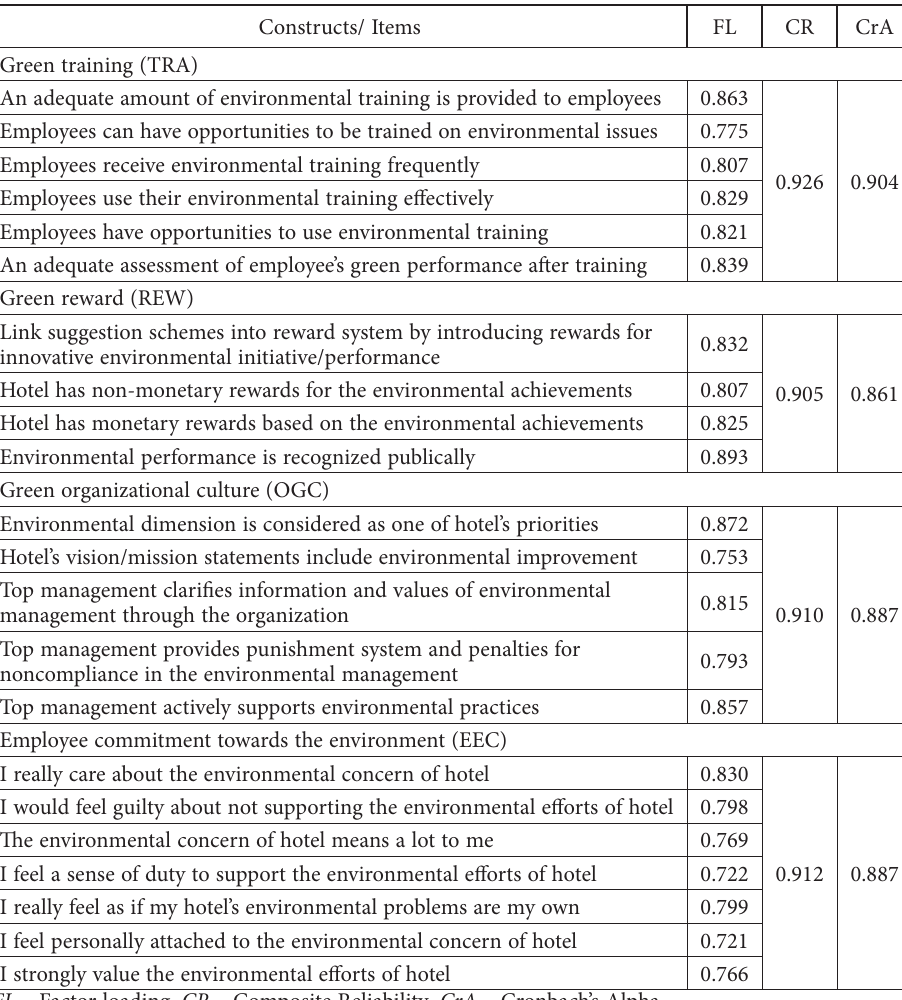
Table 2. Factor loading, Composite reliability and Cronbach’s alpha assessment Constructs/ Items FL CR CrA Green training (TRA)